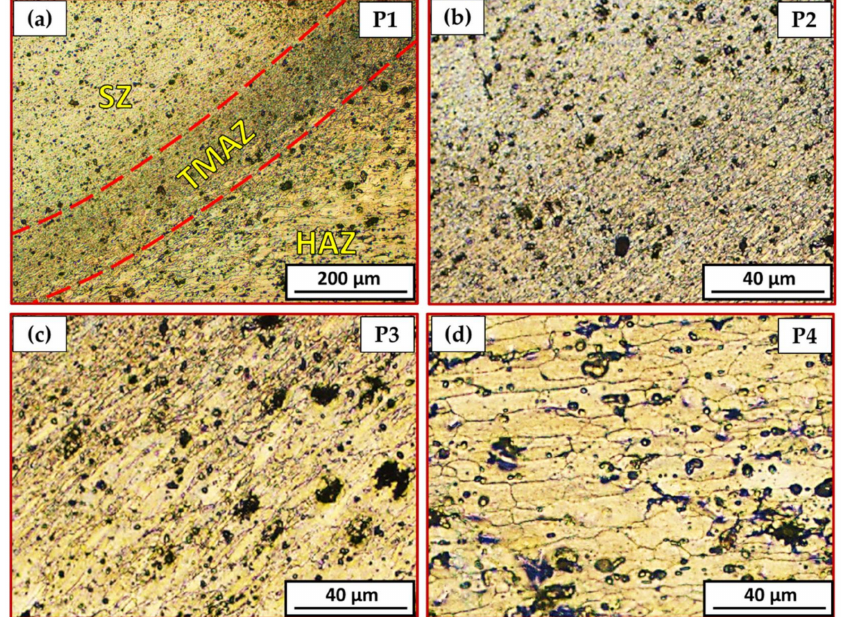
Figure 11. Different microstructure zones of the joint spot welded at 400 rpm where P1 is mixed zone of SZ/TMAZ/HAZ in ( a ), P2 is SZ in ( b ), P3 is TMAZ in ( c ), and P4 is HAZ in ( d ).